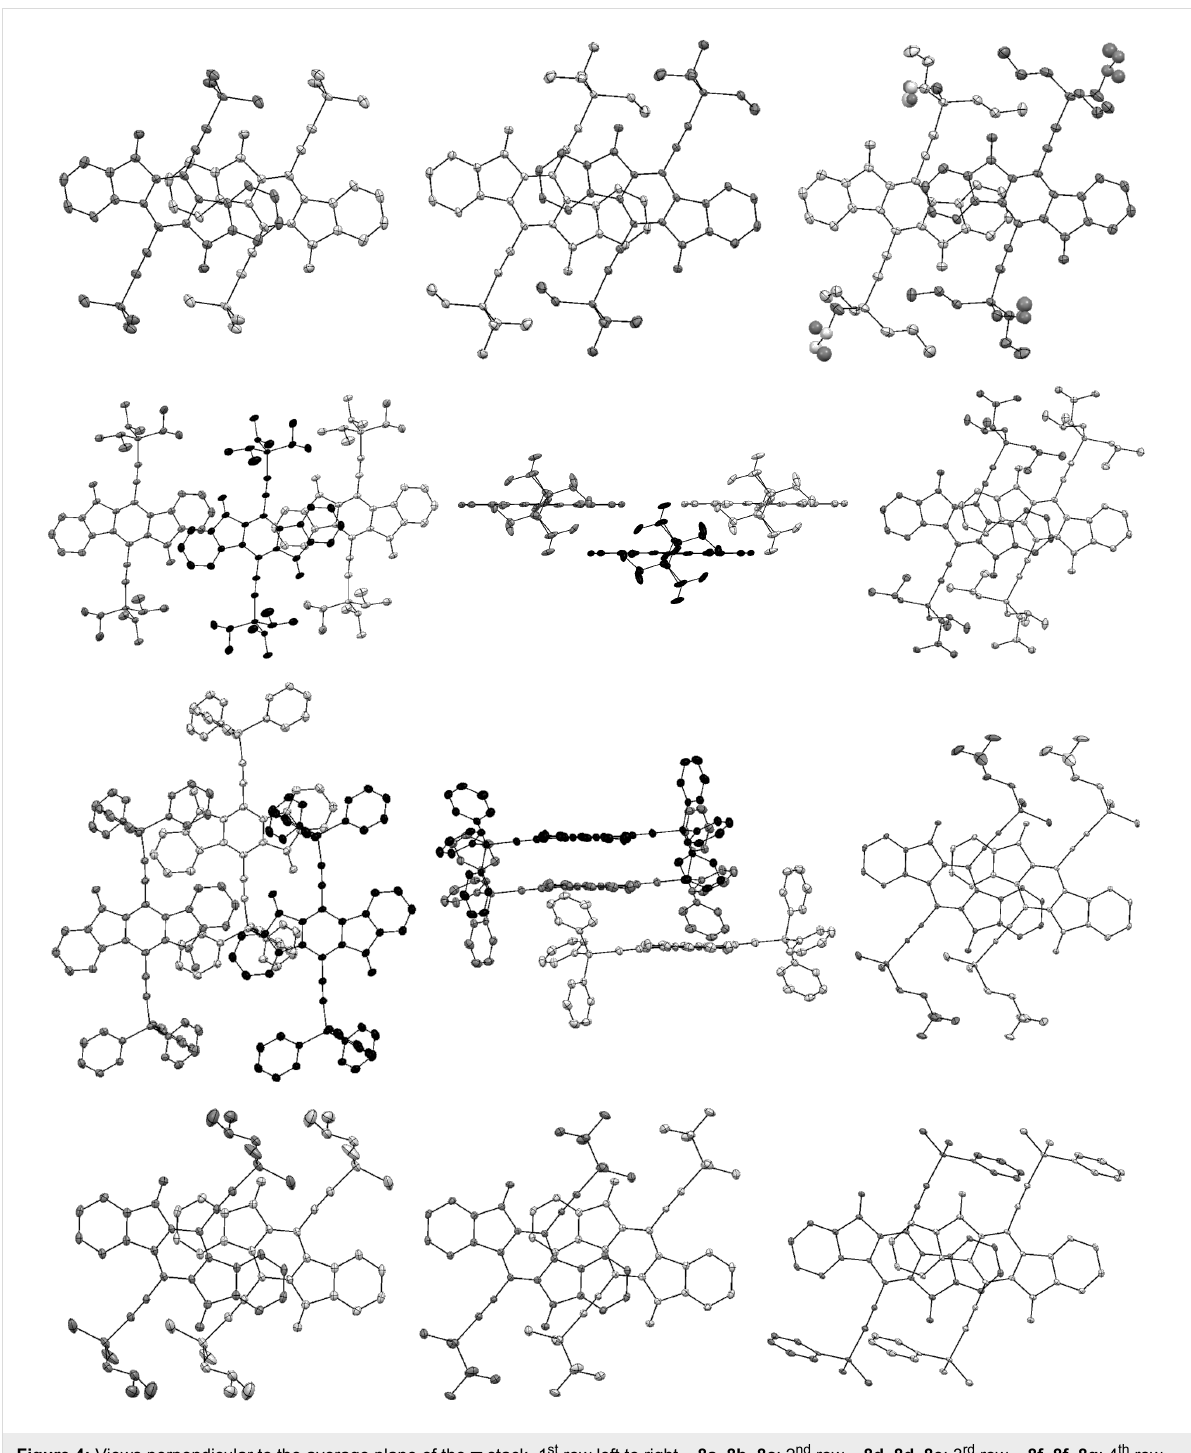
Figure 4: Views perpendicular to the average plane of the π stack. 1 st row left to right – 8a , 8b , 8c ; 2 nd row – 8d , 8d , 8e ; 3 rd row – 8f , 8f , 8g ; 4 th row 8h , 8i , 8j . Hydrogen atoms omitted for clarity; ellipsoids drawn at the 30% probability; individual molecules were colored the same to identify overlap